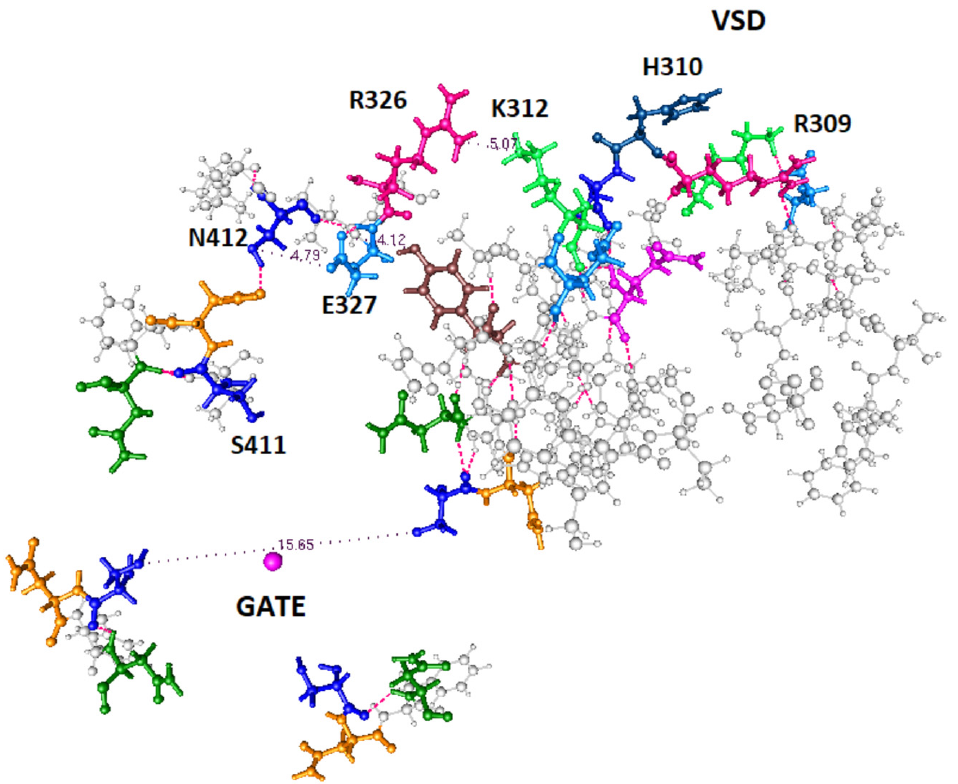
Figure 5. This figure is taken directly from the 3Lut coordinates, and shows the relation of the calculated section, principally the upper path, to the gate and the VSD. Upper path residues are labeled; all else that is included is in gray. R309 and H310 are not part of the calculation, but form the link to the VSD. All four domains at the gate are shown in part, so that the orientation of the linker can be understood.